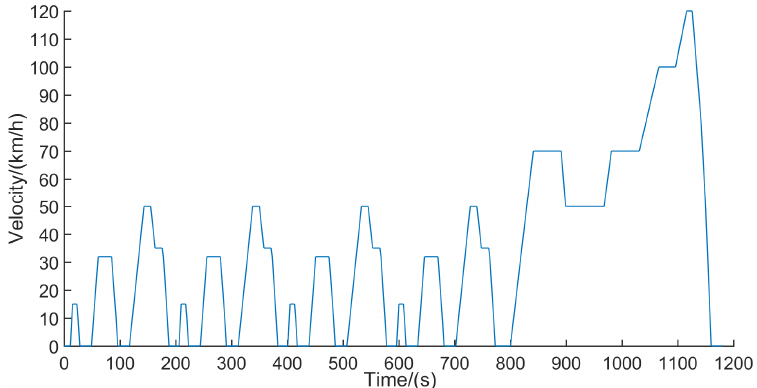
Figure 9. The velocity profile of the New European Driving Cycle (NEDC).